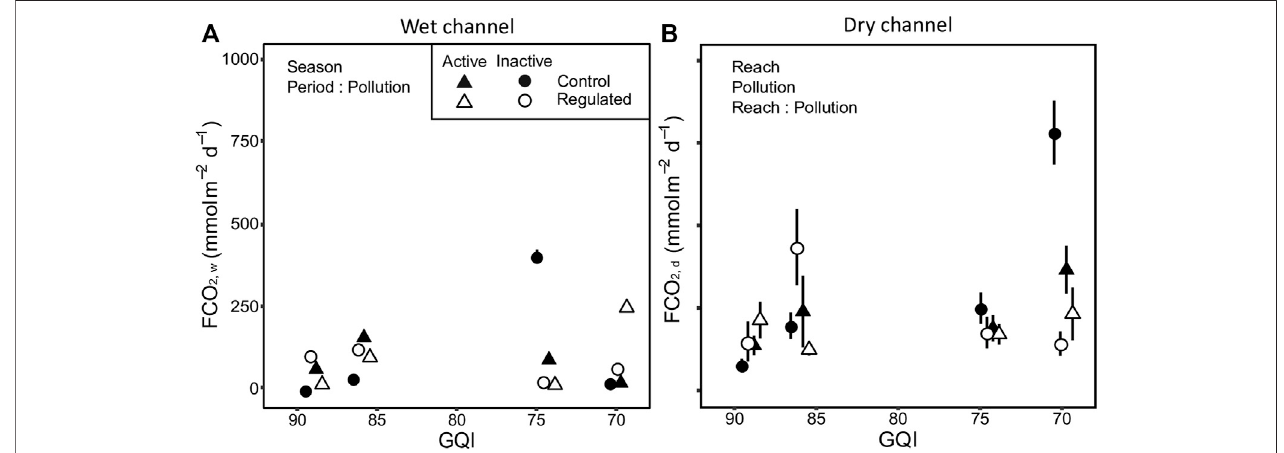
FIGURE4 | CO 2 ef fl ux (FCO 2 ) in (A) wet and (B) dry channel. Values are mean and error bars show standard error. Thetext inthe background indicates signi fi cant single-factor effects or interactions. GQI is the General Quality Index and the scale is inverted to make easier the interpretation of the fi gure, ranging from good (low pollution) to acceptable quality level (moderate pollution). GQI values have been jittered to avoid overlapping